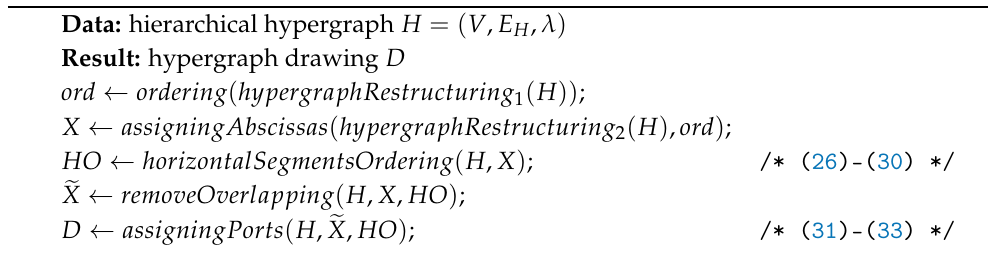
Algorithm 1: A mathematical heuristic for the hypergraph layout.